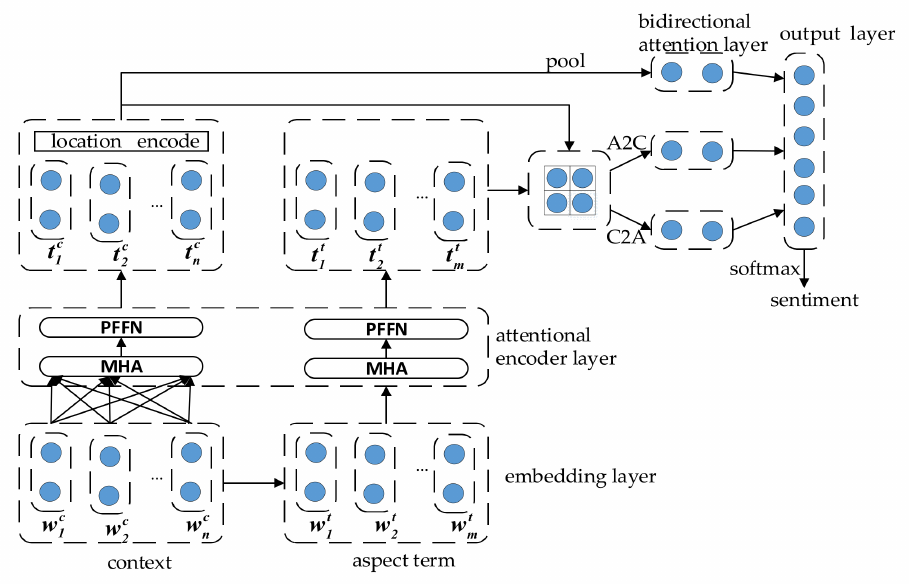
Figure 1. The architecture of MAN model.